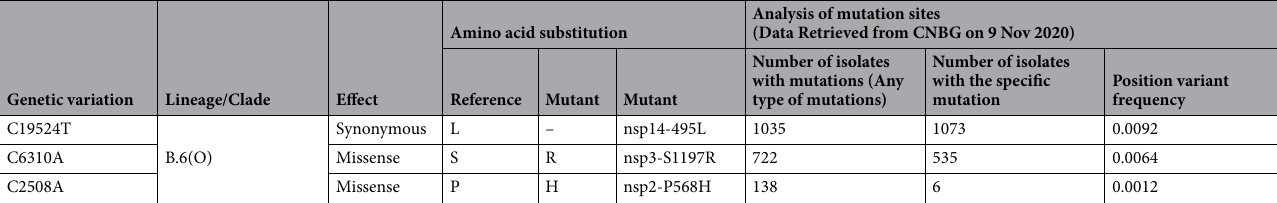
Table 2. List of specific mutations of Malaysia SARS-CoV-2